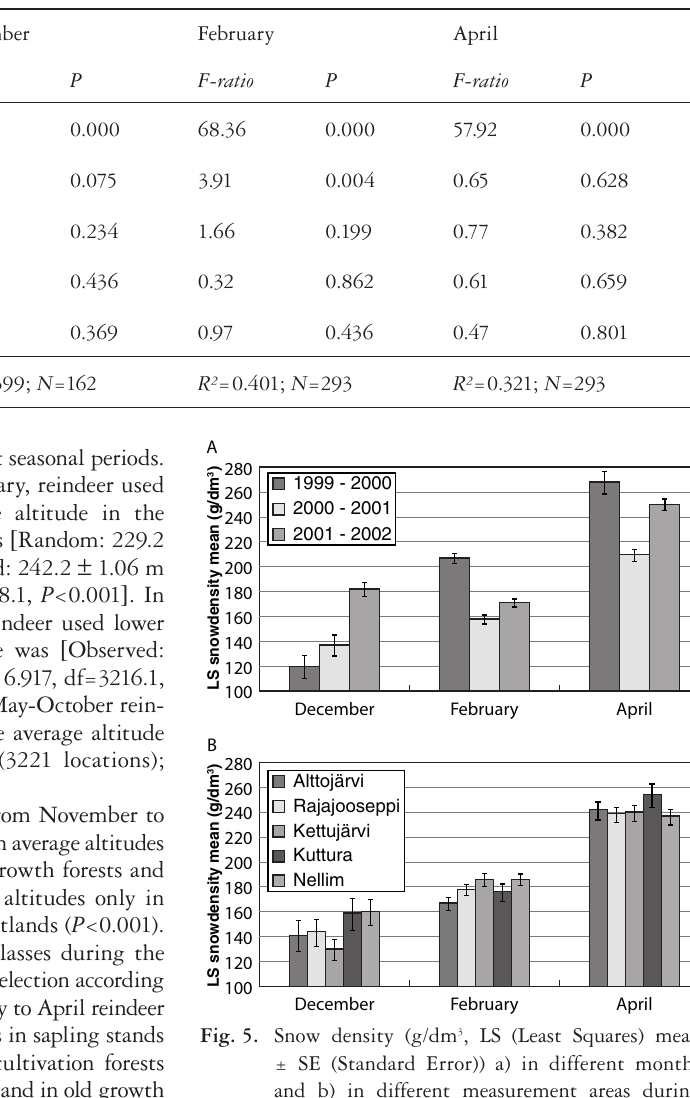
Table 2. Effect of different variables on snow density (g/dm³) in the Ivalo reindeer herding district during three winters (1999 - 2002). Multivariate GLM.